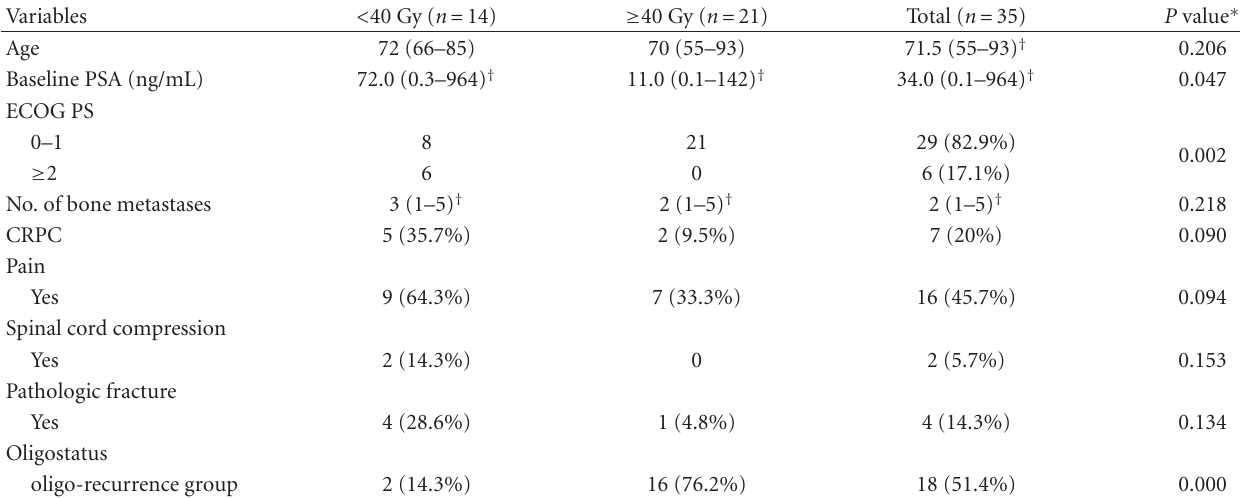
Table 1: Patient characteristics (35 patients).